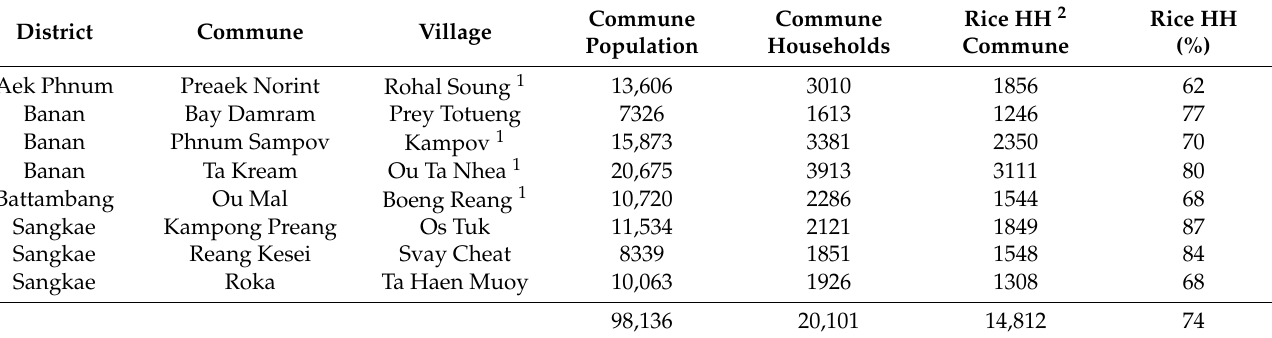
Figure 1. Location of communes surveyed. The areas shaded green were surveyed in 2017 and 2020 and the ones shaded blue were surveyed in 2020 only. Table 1. Population characteristics of target communes and villages [11].